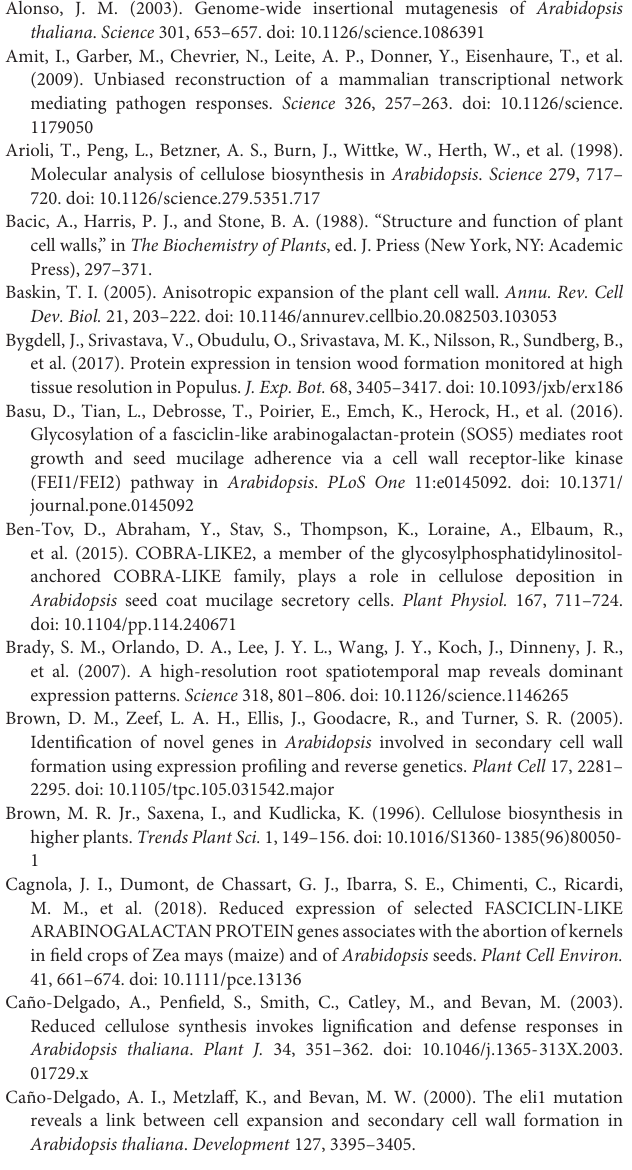
Supplementary Figure 11 | Expression of FLA18 suppresses the fla18-1 primary root hyper-sensitivity to the ABA-synthesis inhibitor, Fluridon. Supplementary Figure 12 | Expression of genes involved in ABA signaling and metabolism in fla -mutant background. Supplementary Figure 13 | Histochemical Staining of the fla18-1sos5 double mutant with phloroglucinol. Supplementary Table 1 | The genes used as ‘baits’ for the tissue-specific co-expression analysis. Supplementary Table 2 | Primers used in this study. Supplementary Table 3 | Probes used in the nCounter NanoString analysis for gene